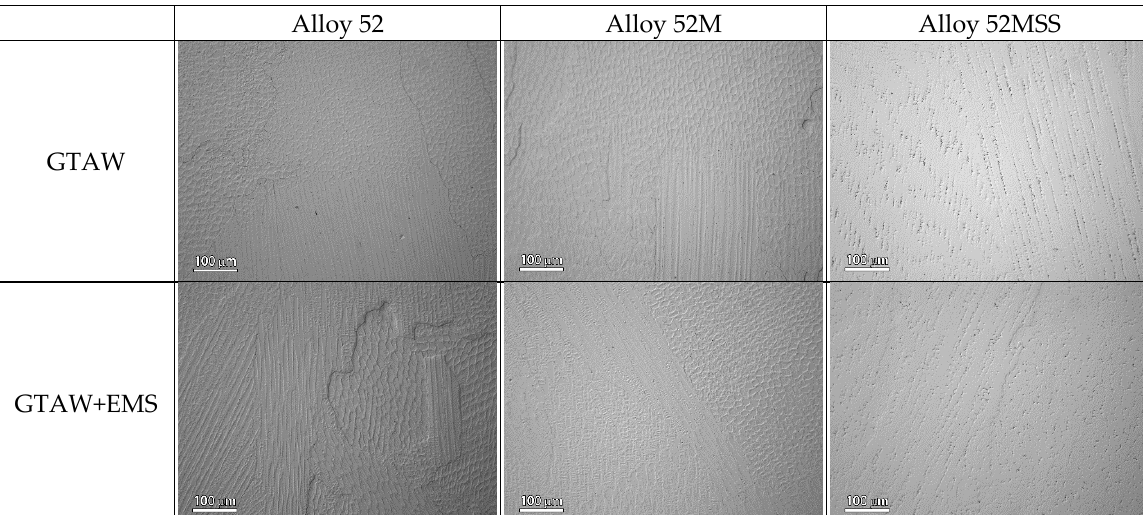
Figure 7. Micrographs of welds in the root. 3.1.2. SEM Observation and EDS Analysis Figure 8 shows the SEM micrographs of Alloy 52 welds. Without EMS, cellular den- drites were the dominant microstructure in the cap region. There were precipitates with a length of about 600 nm to 1 μ m in the inter-dendritic areas. In the middle region, some precipitates between dendrites were larger than 1 μ m in length. It was also feasible to see fine precipitates of about 50 nm to 150 nm in size precipitated nearby. In the root, the cubic-like precipitates were mostly distributed along the dendrites. For the welds made with EMS applied, the cellular dendrites observed in the cap region were more random and denser, as presented in Figure 8. Despite their sizes at the same level, the precipitates were more evenly distributed in the welds made with EMS applied than those without EMS applied. In the middle region, the cellular dendrites were smaller, and the columnar dendrites shorter. In the root region, the grain boundary cannot be clearly discerned, and the precipitates in the inter-dendritic areas were slender and in a discontinuous island-like shape. The compositional analysis shows that the precipitates in the Alloy 52 weld are Ti(N,C)s. In some cases, Ti(N,C)s are mixed with Al-Mg oxides, as shown in Figure 9. In